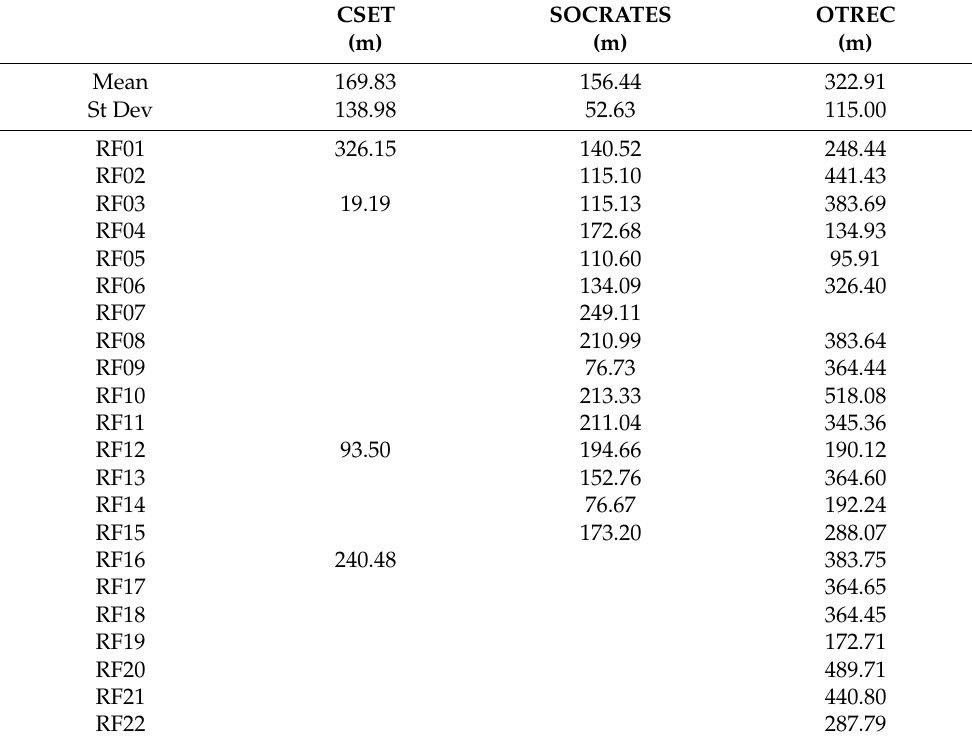
Table 1. Offset (in m) between the 0 ◦ C isotherm and the detected melting layer for all three field campaigns. Positive offsets indicate that the melting layer was located below the 0 ◦ C